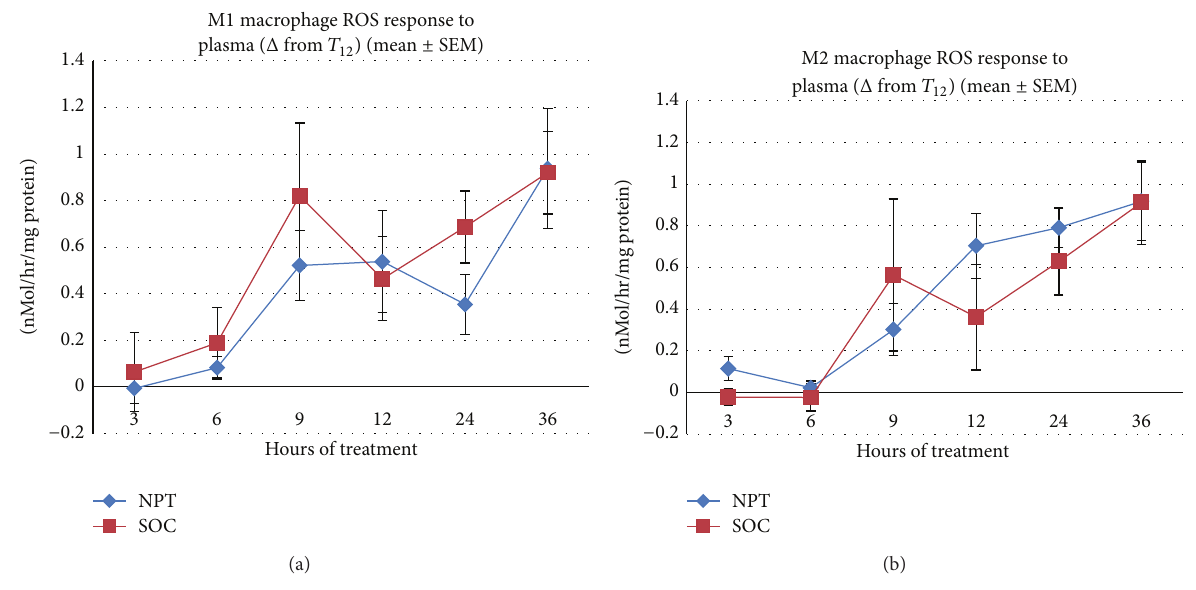
Figure 5: Production of ROS by M1 and M2 macrophages in response to plasma from septic swine in vitro . The production of ROS by human macrophages was induced in vitro with plasma taken from swine at various intervals following the induction of septic injury, and the results are expressed as the difference ( Δ ) from the initiation of treatment at the 12 hrs interval ( 𝑇 12 ), representing a 36 hrs period of treatment. There were no differences between treatment groups when M1 macrophages (a) or M2 macrophages (b) were incubated with